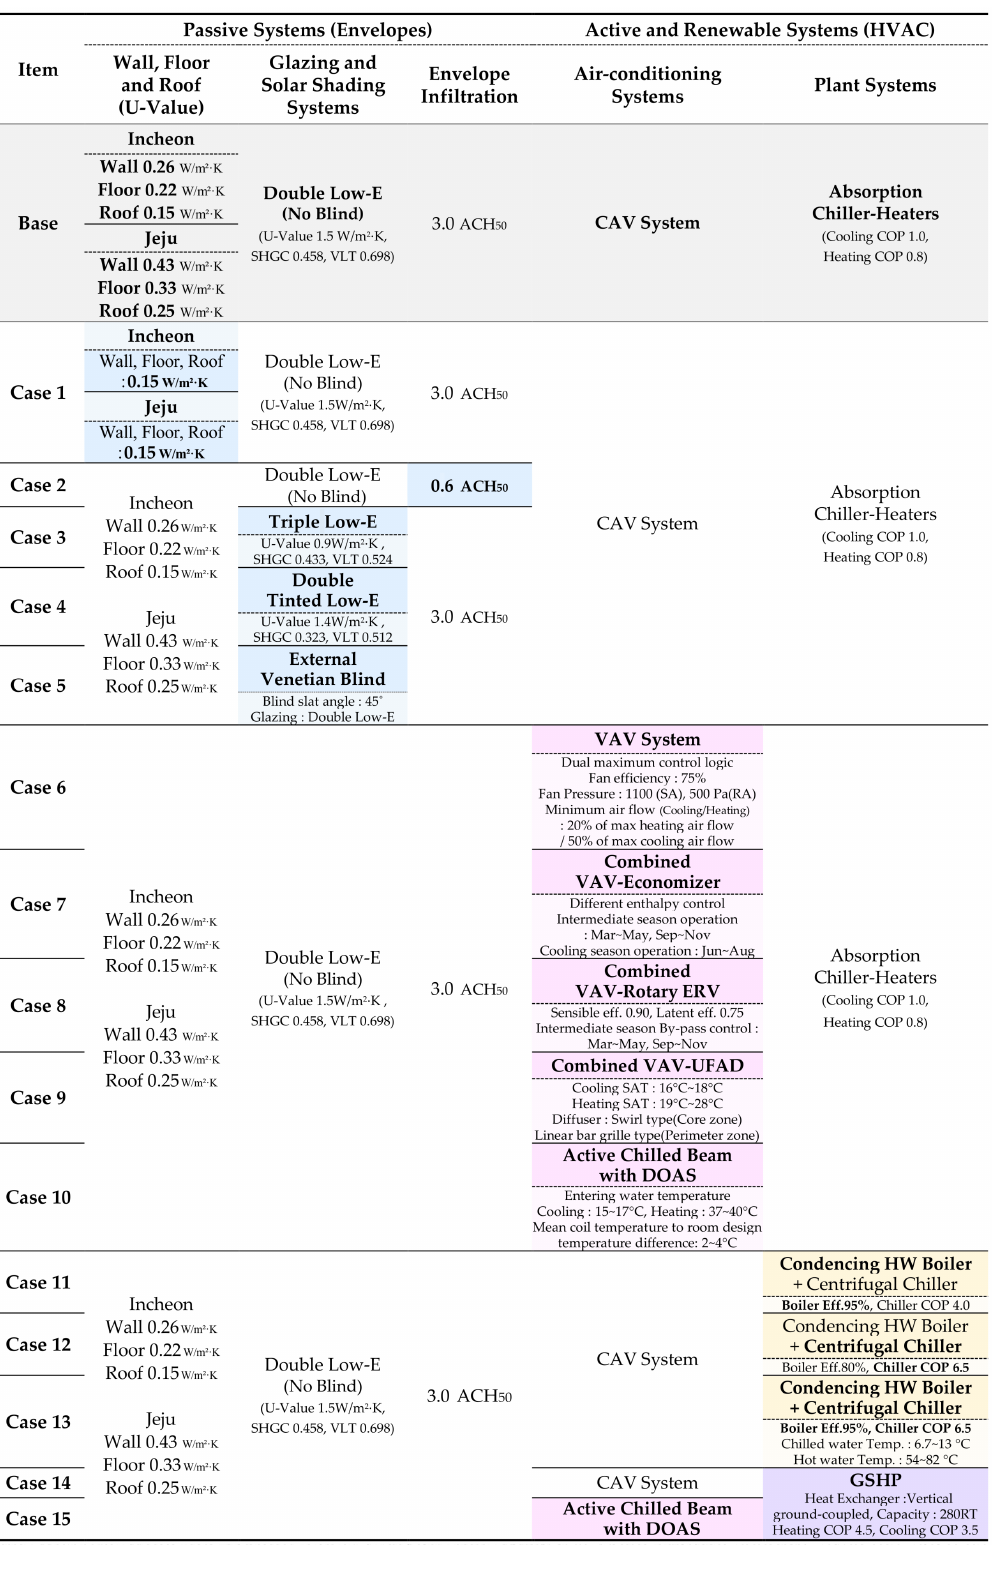
Table 8. Set of simulation variables (passive, active, and renewable energy systems for energy saving). (Grey: base, Blue: passive systems, Pink: air-conditioning systems, Yellow: plant systems, Purple: renewable